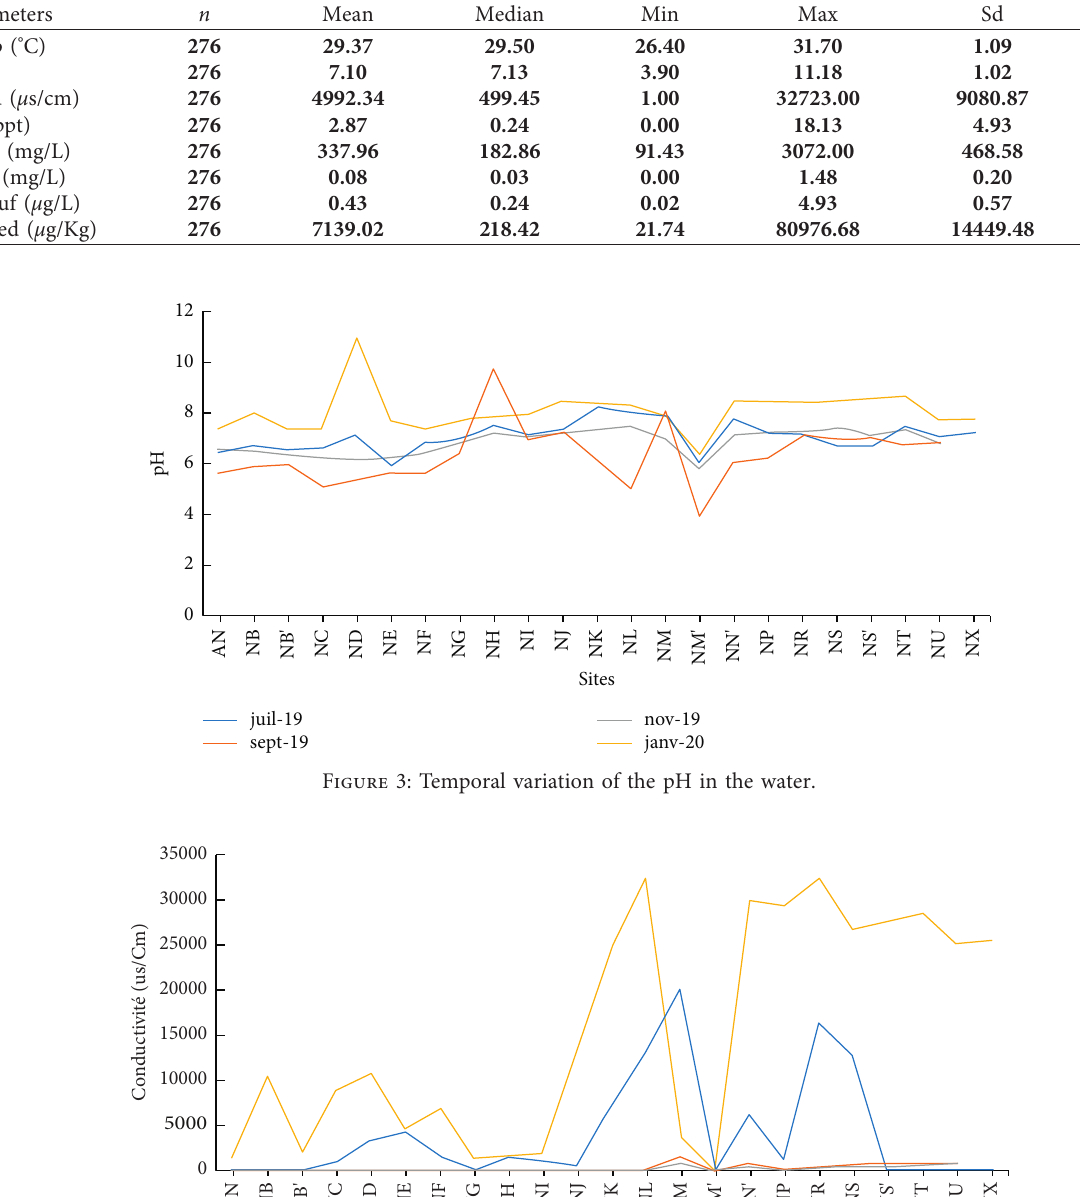
Table 2: Statistical data of the physicochemical parameters of water.